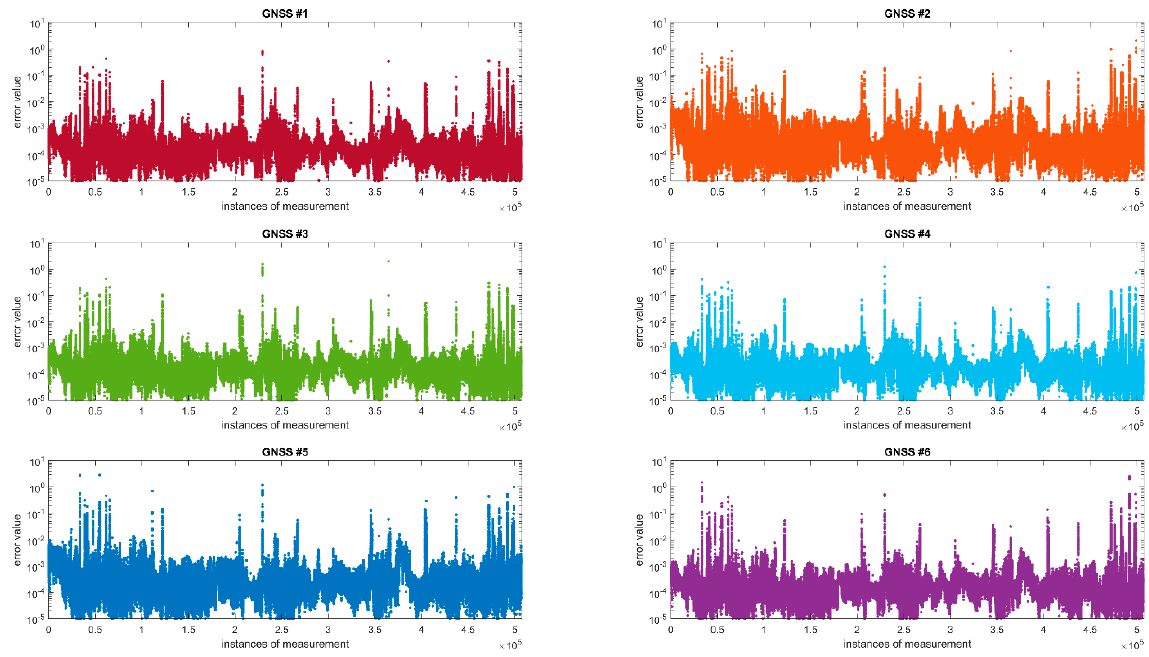
Figure 6. Distributions of the antennas’ position errors over the test section.